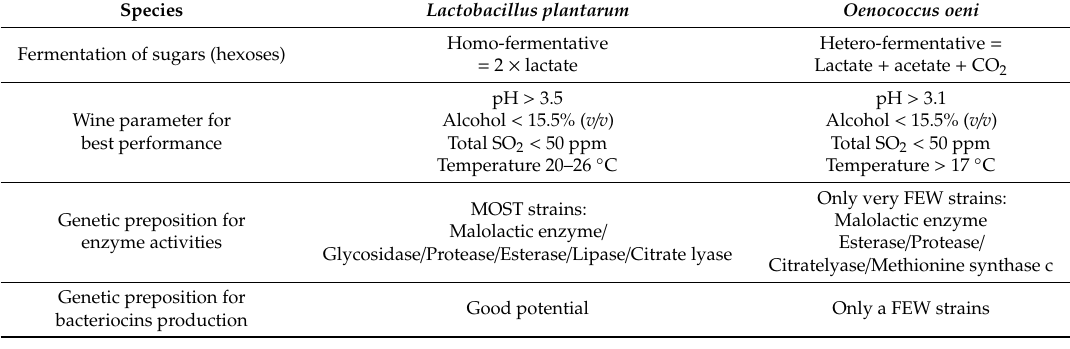
Table 1. Characteristics of Lactobacillus plantarum vs. Oenococcus oeni.